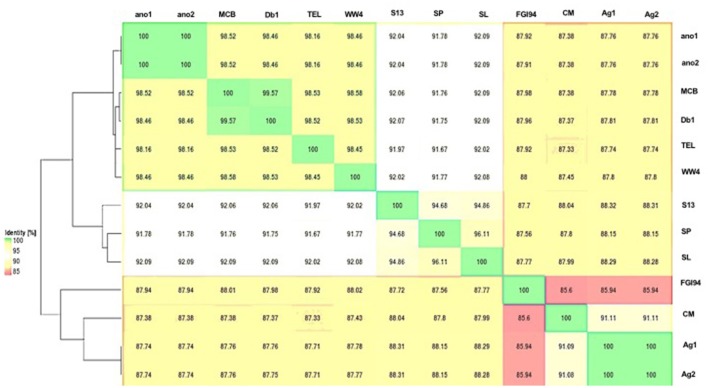
Average nucleotide identity dendogram for the selected Serratia spp. ANI matrix generated by complete genome sequences was used to calculate an ANI divergence dendrogram. The hosts for these isolates were shown on the right panel. Ano1, S. marcescens ano1; Ano2, S. marcescens ano2; Ag1, Serratia sp. Ag1; Ag2, Serratia sp. Ag2; MCB, S. marcescens MCB; Db11, S. marcescens Db11; TEL, Serratia sp. TEL; FGI94, S. marcescens FGI94; Sp, S. plymuthica S13; Sl, S. liquefaciens ATCC 27592; WW4, S. marcescens WW4.